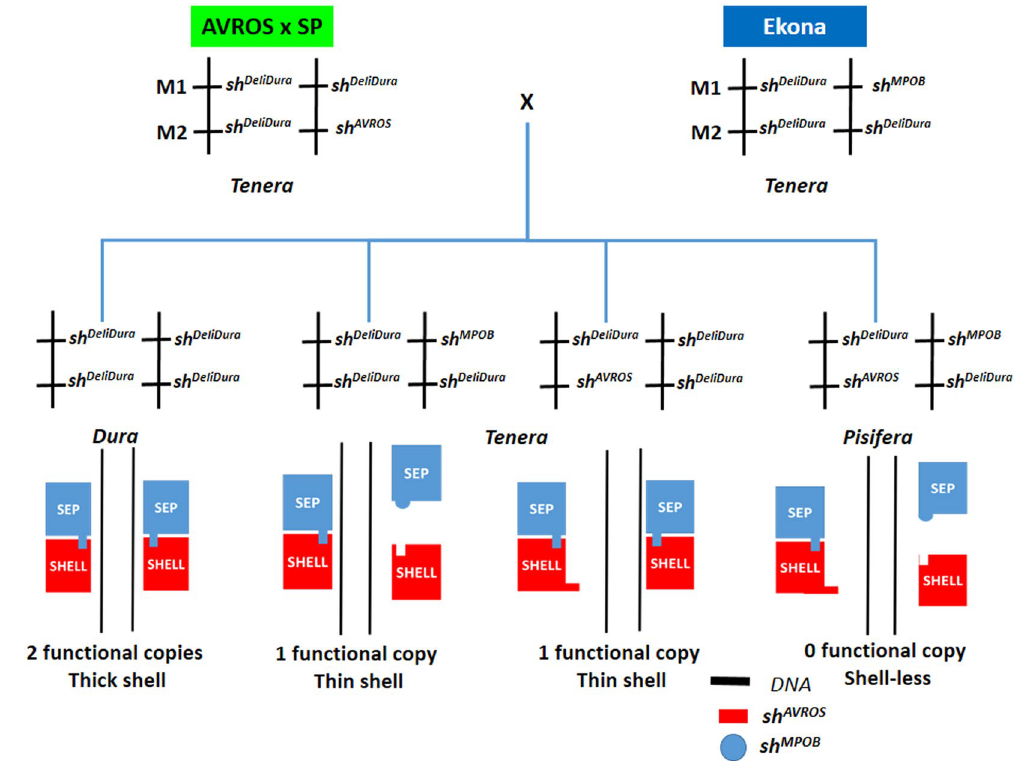
Figure 3. The mapping of genotype-phenotype relationships on an AVROS-SP tenera × Ekona tenera hybrid population and SHELL-SEP-like protein interaction model in three fruit forms influenced by functional copy (haploinsufficiency effect). The pisifera fruit form was due to trans-compound heterozygosity in SHELL